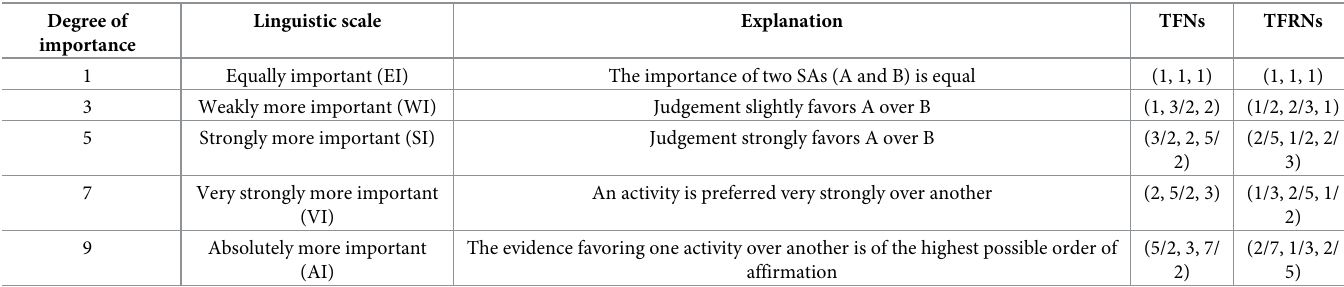
Table 5. Linguistics measurement of importance scale